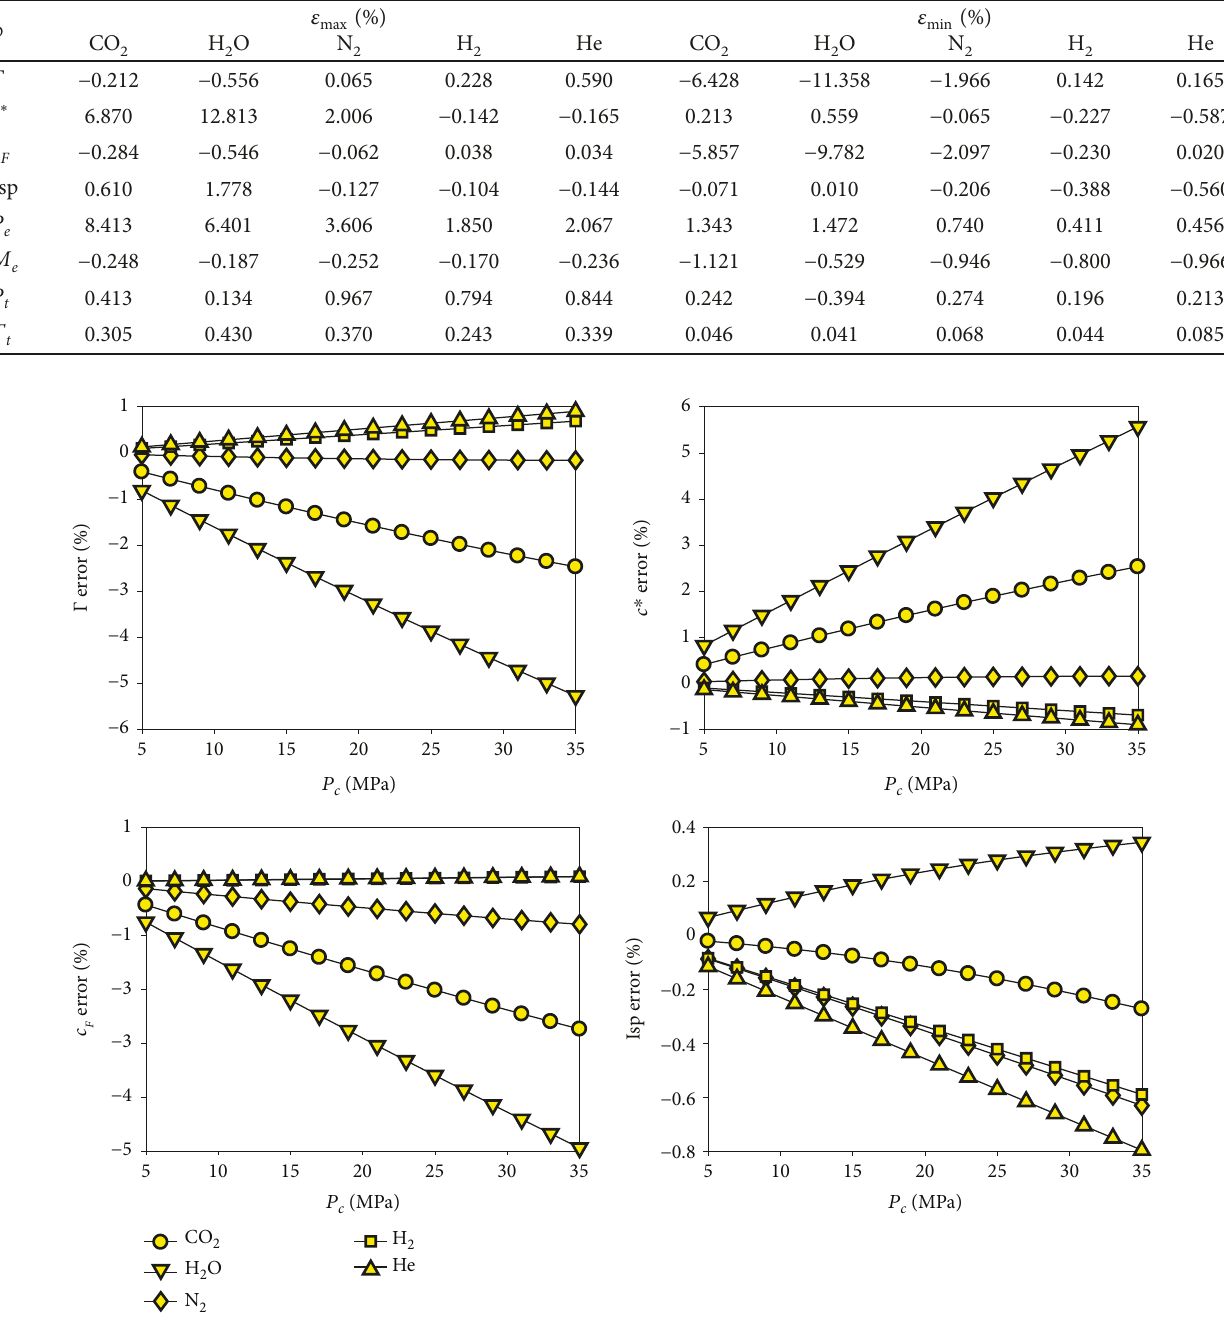
Figure 3: Errors of propulsion parameters of thermally perfect ideal gases with respect to VDW gases versus chamber pressures, for vacuum / A = 100 and T = 2500 expansion, A e t c